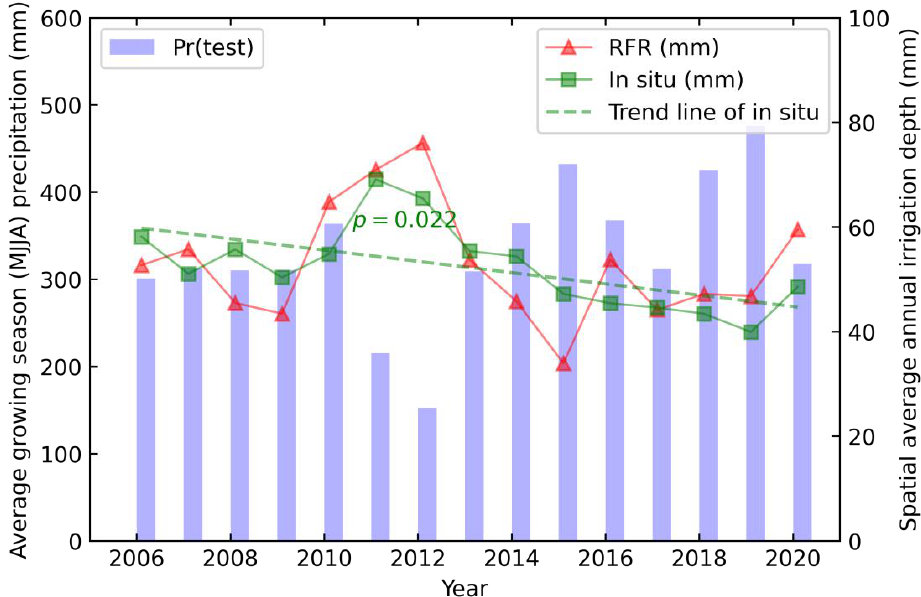
Figure 4. Annual growing season (May, June, July, August, MJJA) total precipitation (bars) and irrigation amounts as depth (mm) from the RFR (red, triangle) and in situ records (green, square) for the entire Kansas HPA from 2006 to 2020 in Experiment A (random split). Linear regression (green, dashed) of the in situ irrigation amount has a decreasing trend ( 𝑝 = 0.022) . The irrigation amount estimated by the RFR does not have a statistically significant decreasing trend.